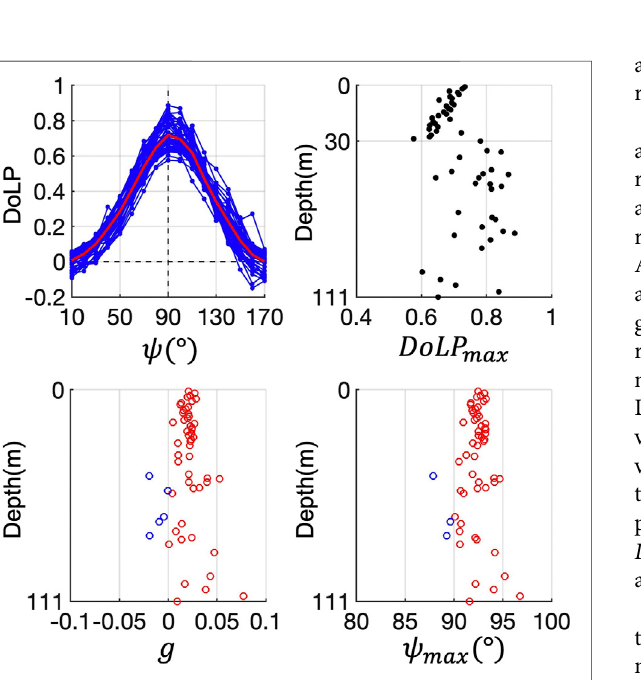
FIGURE 7 | Ensemble averaged particulate DoLP. Measured DoLPs from all fi eld sites are grouped together and then averaged into 1-m depth bins. The mean is overlaid as the red curve. Vertical pro fi les of the peak magnitude DoLP max , asymmetry parameter g and peak angle ψ max are displayed. g > 0 data points are indicated with red circle; g < 0 data points are indicated with blue circle. ψ max > 90 ° data points are indicated with red circle; ψ < 90 ° data points are indicated with blue max